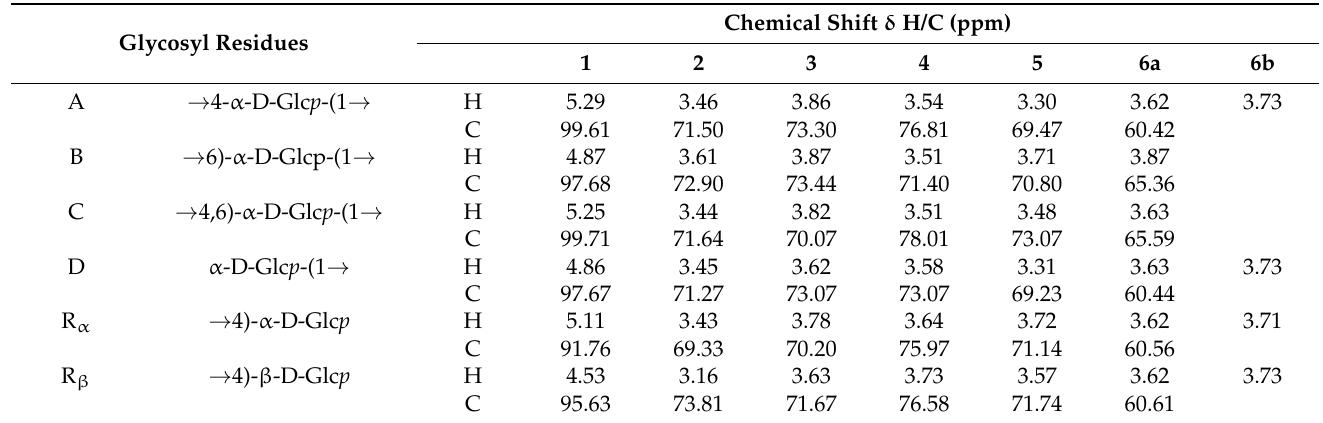
Table 2. 1 H and 13 C NMR chemical shifts (ppm) of NPPc in D 2 O. Glycosyl